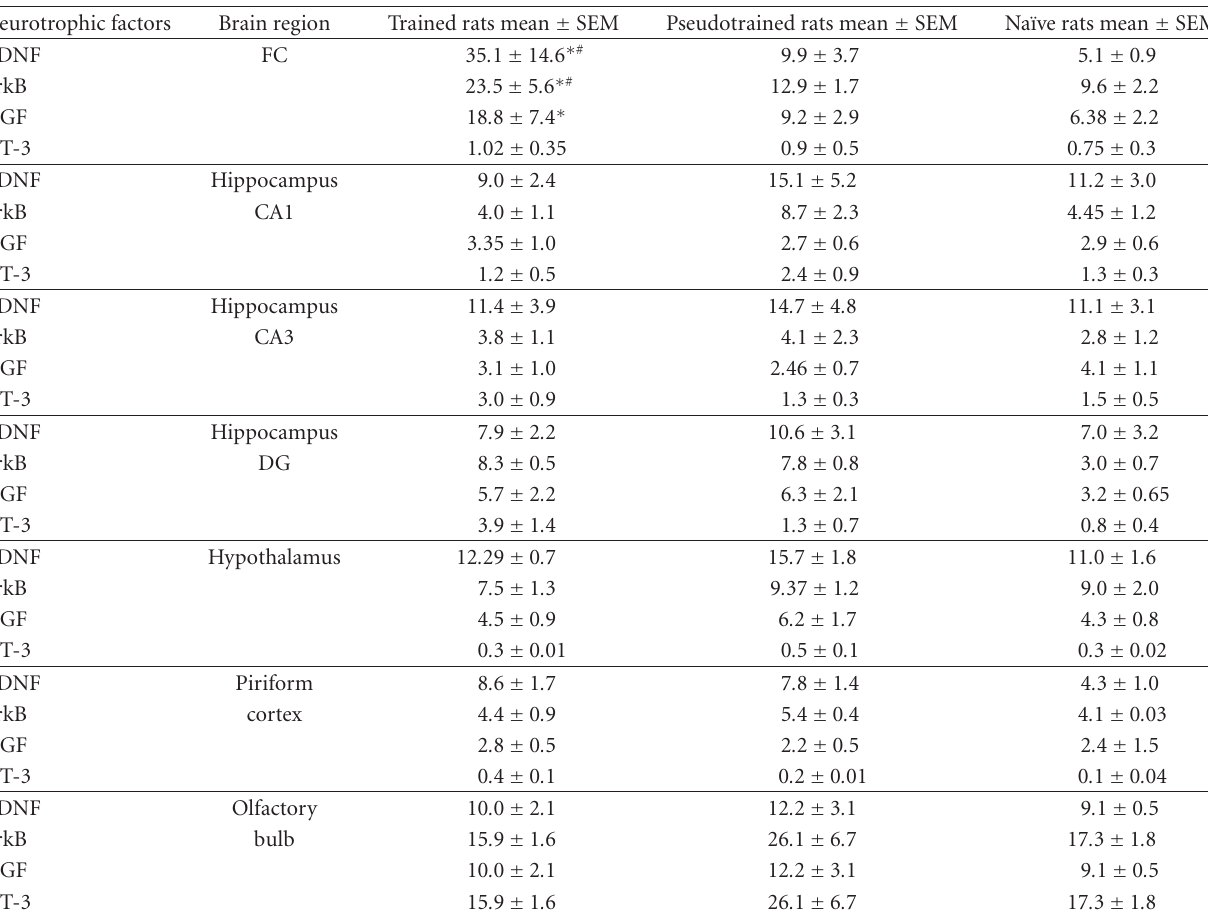
Table 1: Neurotrophic factors and TrkB mRNA levels expression/ β -actin in di ff erent brain regions amongst groups. mRNA levels are expressed as mean ± SEM ( n = 12 in each group) arbitrary unit of each neurotrophic factor or TrkB relative to mRNA levels of β -actin. Each sample was run in duplicates.